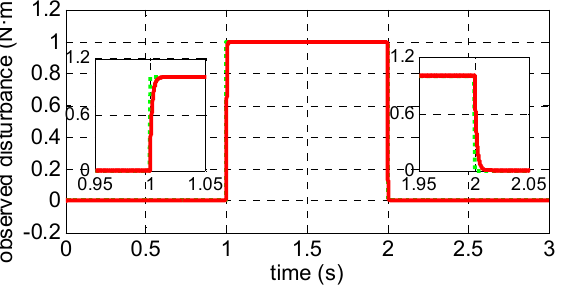
Figure 10. Simulation curves of observations based on the extended sliding mode observer (ESMO) for a step disturbance of 1 N ∙ m.